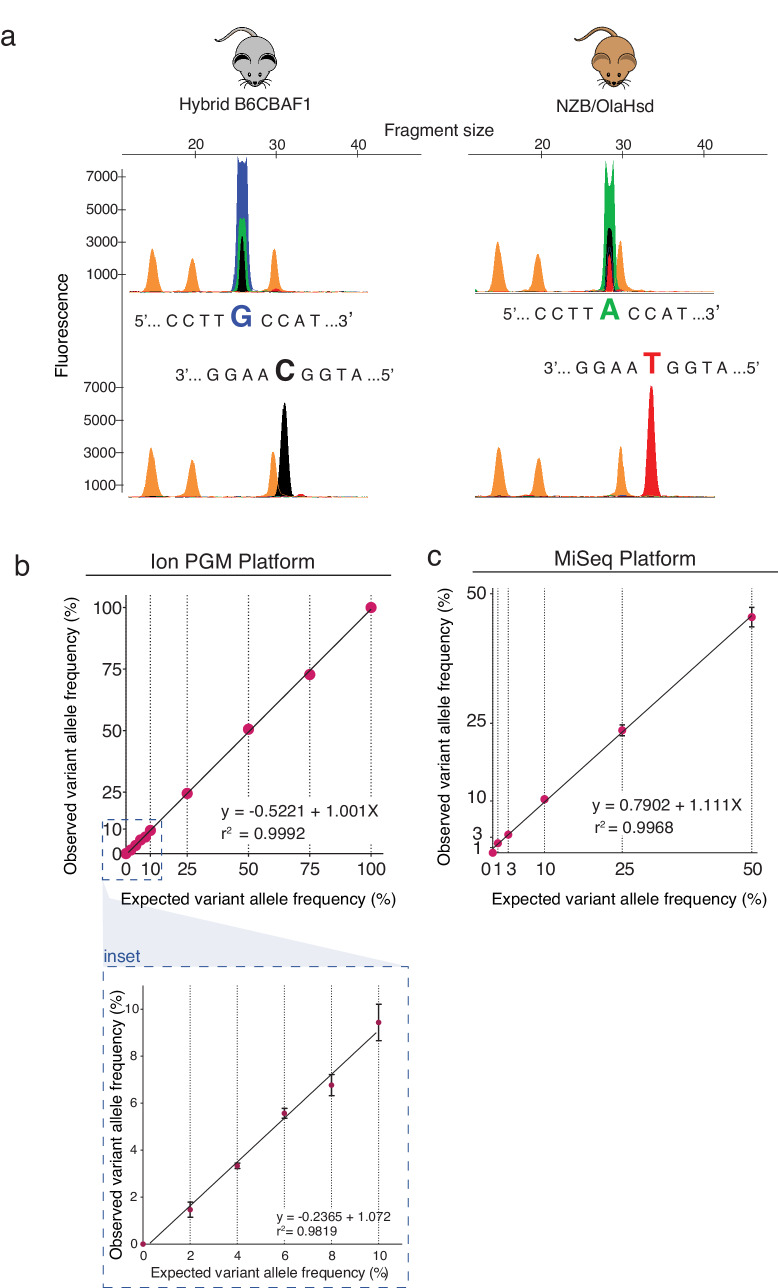
Validation of established high-throughput sequencing protocol for mtDNA carryover analysis.(a) Results of SNP minisequencing analysis. The presence of guanine (G) or adenine (A); and cytosine (C) or thymine (T) at position m.3932 on the forward and reverse mtDNA strands of B6CBAF1 or NZB strains was confirmed by minisequencing. (b-c) Expected and observed variant allele frequencies at position m.3932 using Ion PGM (ThermoFisher) (b) or Illumina MiSeq plaforms (c). A high accuracy of the established sequencing method was obtained when analyzing allele frequencies at position m.3932 in homoplasmic samples and artificially constructed heteroplasmic samples. Error bars show standard deviation. Bottom panel shows a zoom inset. Linear regression was performed with Prism 6.0 software.